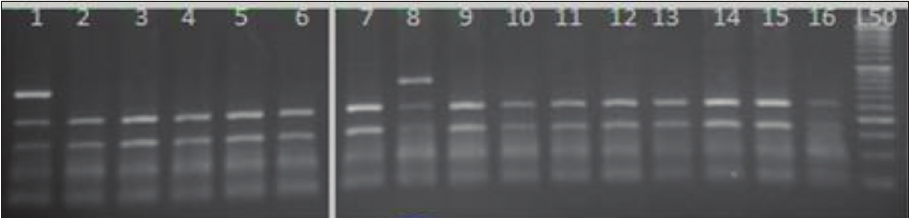
Figure-6: Agarose gel electrophoresis (4%) displaying Hha I digest on an amplified exon1of Watish Fec G -G1 gene. Lanes 2-7, 9-16: Represent++. Lanes 1, 8: (G+) lane L: 50 bp DNA ladder.